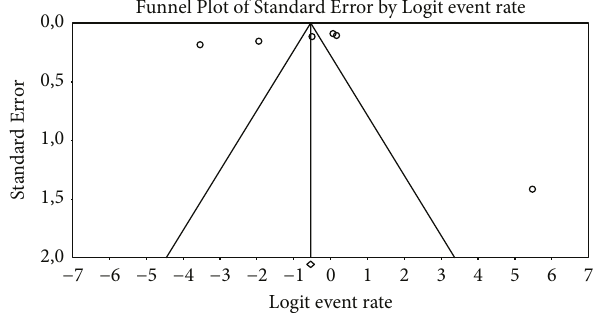
Figure 6: Funnel plot with 95% confidence limits of the pooled prevalence of the studies conducted in Eastern Cape